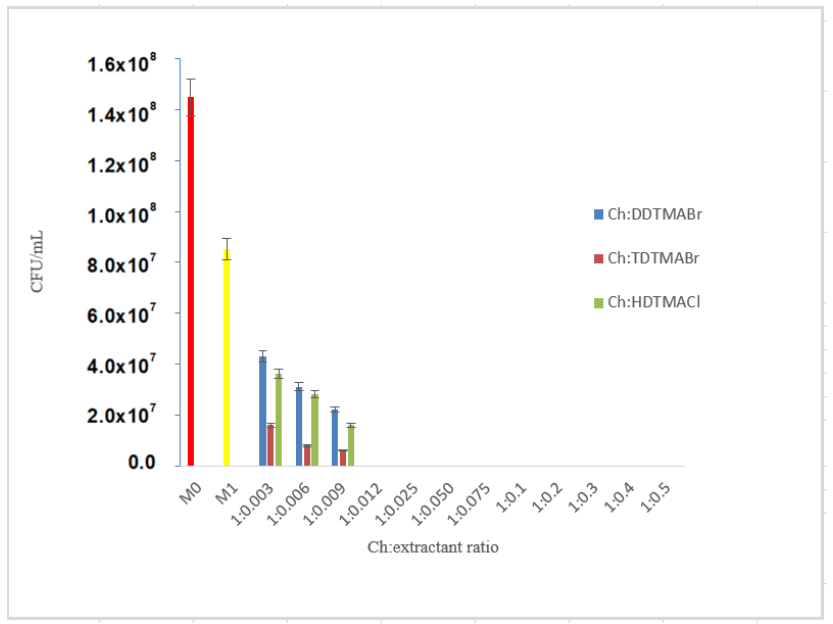
Figure 5. Comparison of control sample (M0)—Ch (M1)—Ch:functionalized with quaternary ammonium salts.